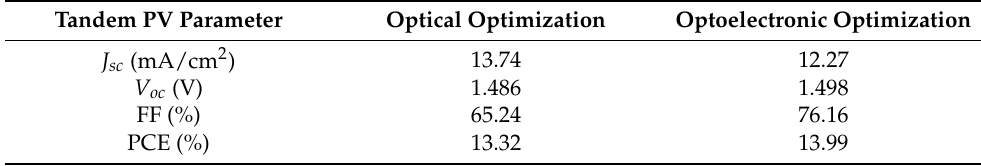
Table 2. Key tandem factors based on optical and full optoelectronic optimization. Tandem PV